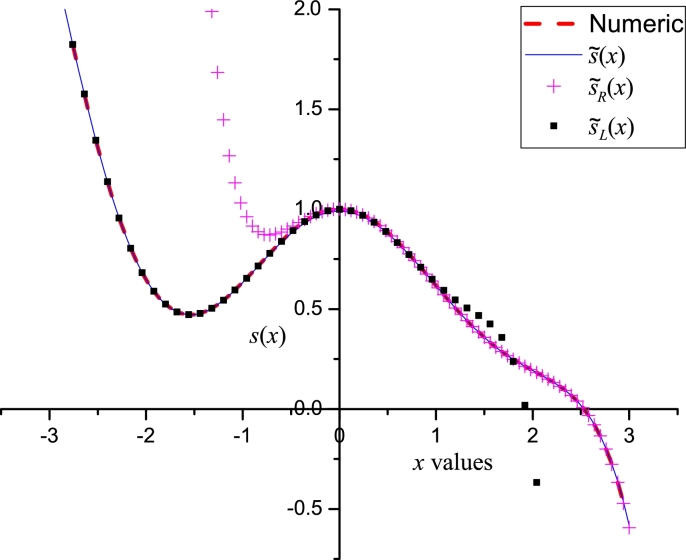
Comparison among the numerical solution of (38) and (41), (43) and (42).